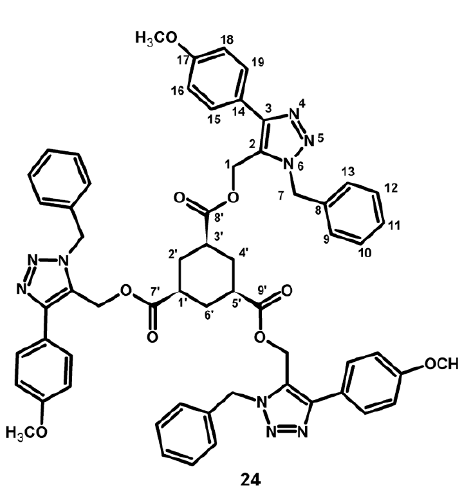
Figure 1. Structure and numbering of the final product 24